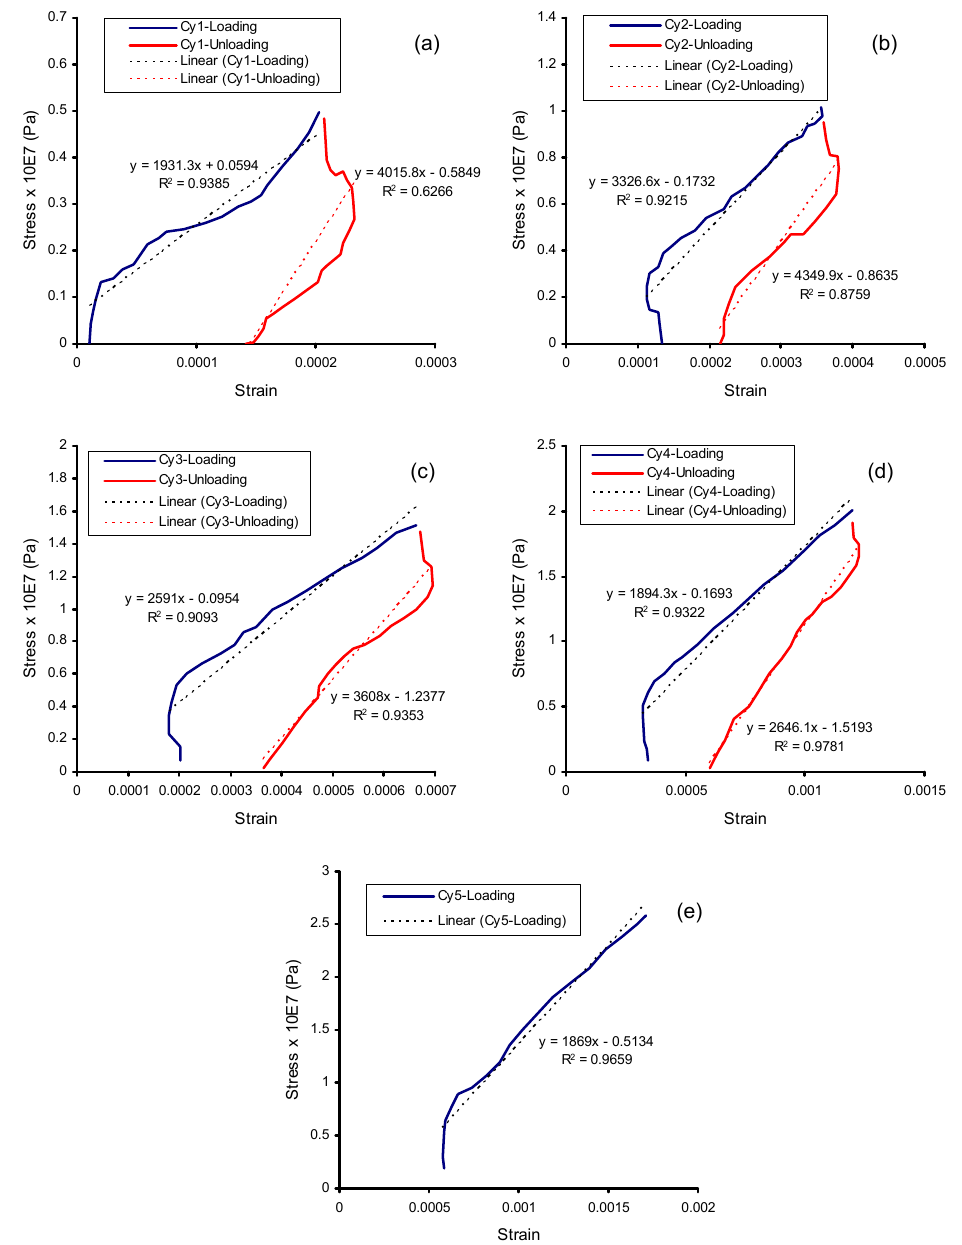
Figure 11. Stress-Strain curves and linear fits for five loading-unloading cycles; determined at a depth of 60 cm: ( a ) 1st cycle, ( b ) 2nd cycle, ( c ) 3rd cycle, ( d ) 4th cycle, ( e ) 5th cycle [21].